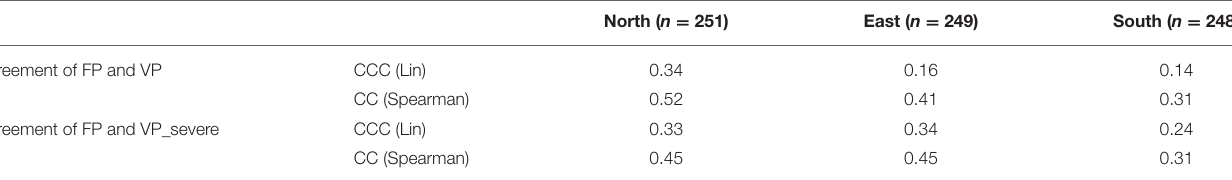
TABLE 2 | Agreement of the lameness prevalence estimated by the farmer (FP) and the prevalence of lame (VP) and severely lame (VP_severe) cows assessed by the researchers.